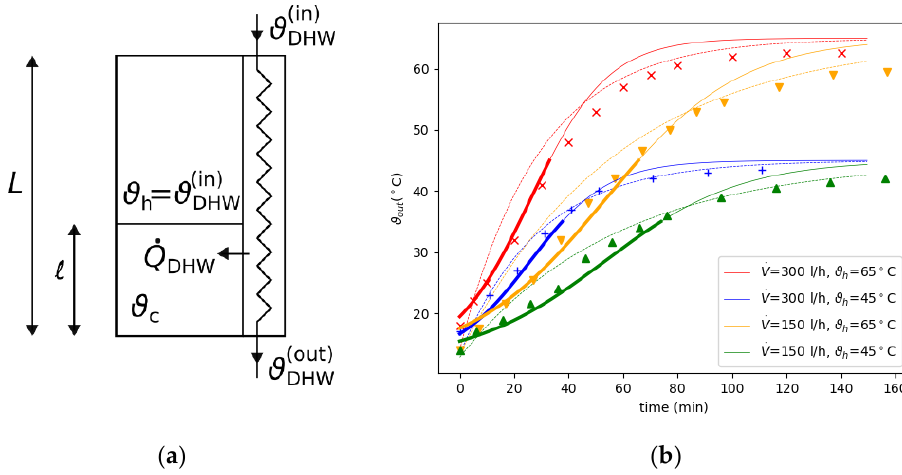
Figure A1. ( a ) Scheme of the moving boundary approach. ( b ) Fitting (A12) to experimental data of a charging process of a 140 L enerboxx ®® storage (storage used in [28]) for different temperatures and volume flow rates. The solid lines in ( b ) represent the moving boundary approach calculated from (A12), the dotted line represent a lumped parameter approach (not described) and the markers denote measured temperatures from the experiment.